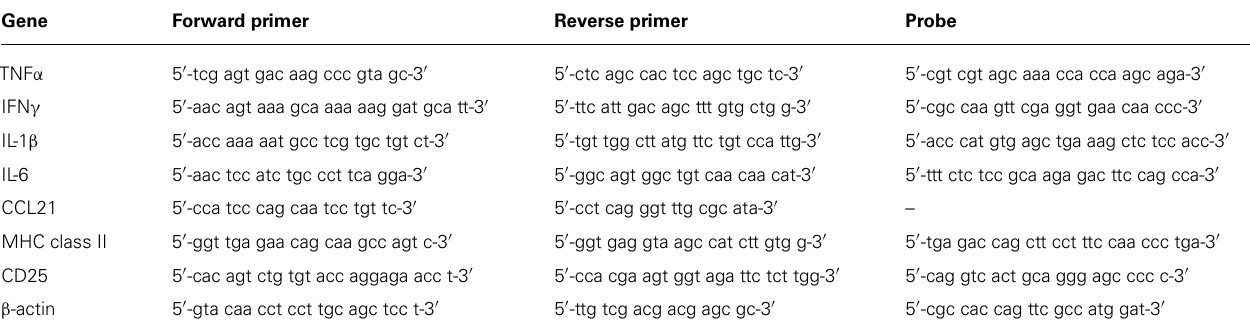
Table 1 | Primer and probe sequences used for real-time RT-PCR